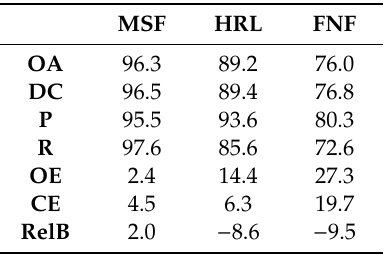
Table 5. Performance metrics of MSF, HRL and FNF